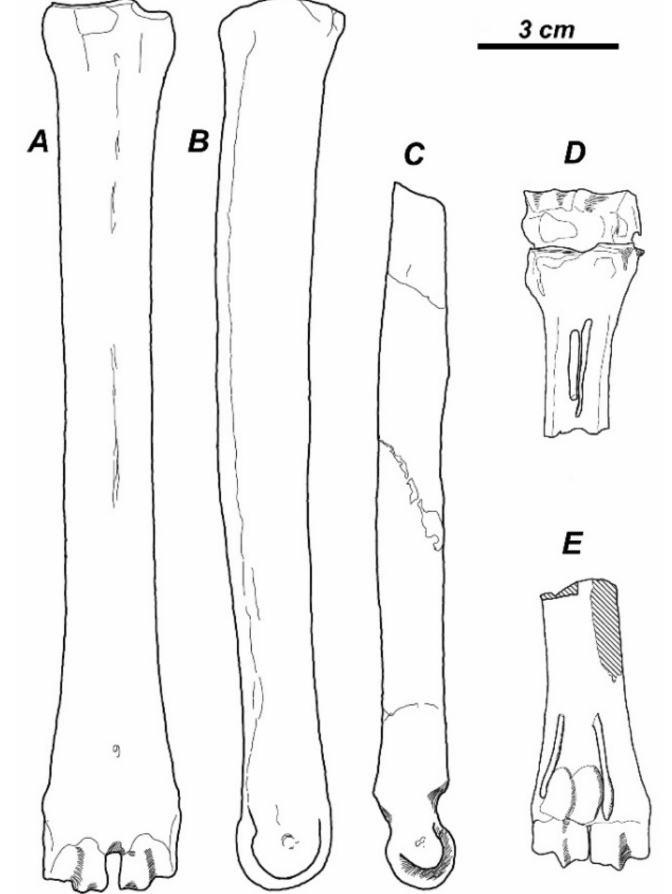
Figure 2. Holometacarpal limbs in Cervidae: ( A – C ); Metadicrocerus variabilis from the late Miocene of Ukraine showing a strong development of distal articulation in lateral metacarpals: ( A ), dorsal vies of metacarpal III–IV; ( B ), side view of metacarpal III–IV; ( C ), side view of lateral metacarpal II [18]; ( D , E ), “ Cervocerus novorossiae ” from the Pliocene of Shansi with completely lost distal articulations of lateral metacarpals: ( D ), plantar view of proximal metacarpal III–IV with articulated carpal bones and proximal parts of lateral metacarpals II and V; E, plantar view of distal metacarpal III–IV with distal parts of metacarpals II and V